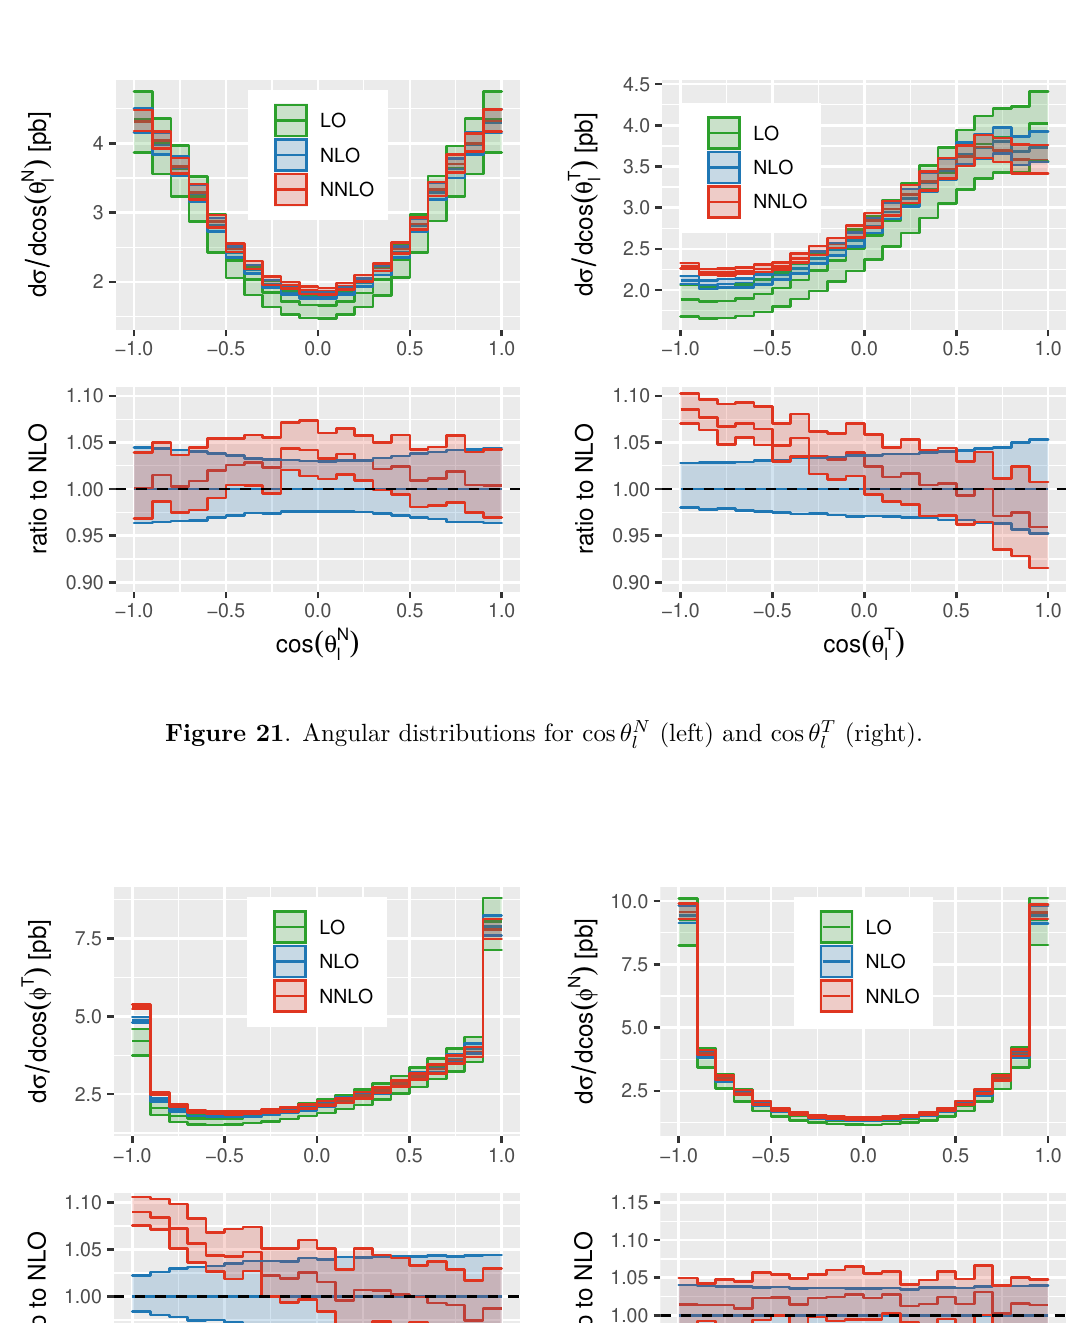
Figure 22 . Angular distributions for cos φ T (left) and cos φ N